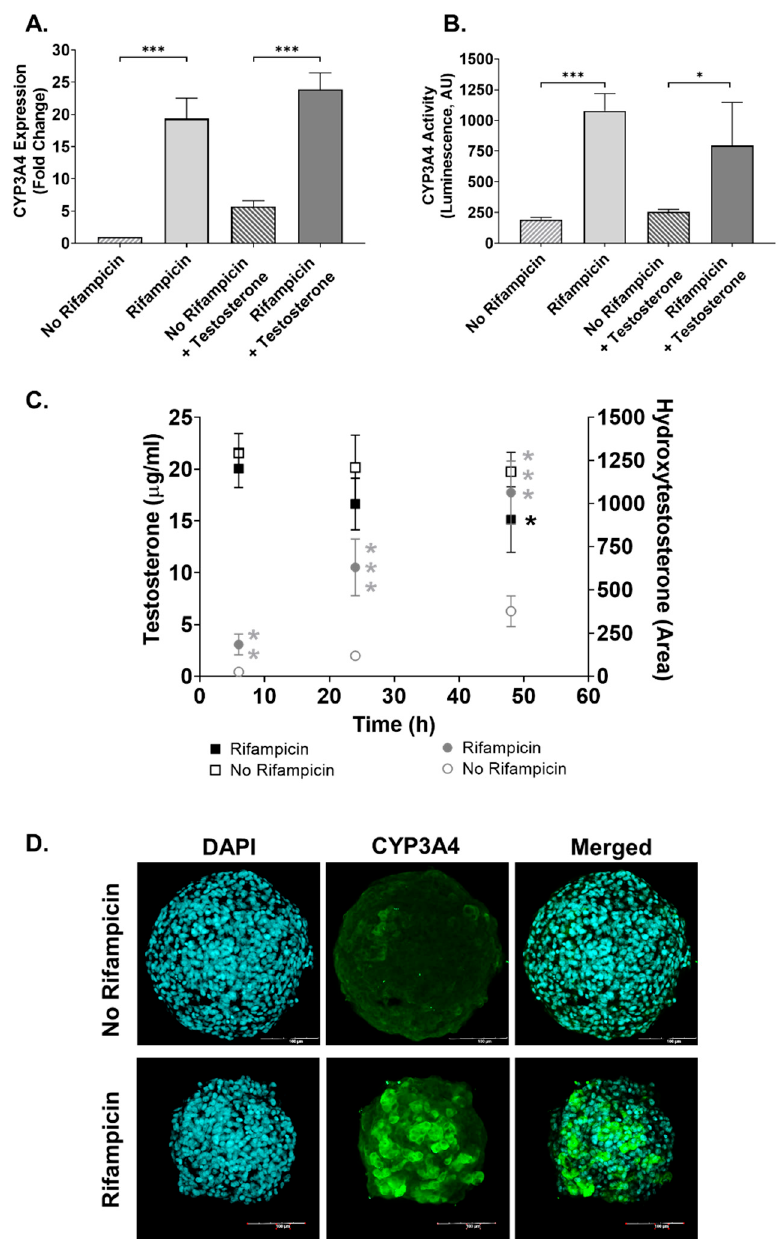
Figure 1. Characterization of CYP3A4 activity in 3D human liver MTs. MTs were exposed to 20 µM rifampicin (RIF), and RIF-treated and untreated MTs were exposed to 25 µg/mL testosterone for a further 48 hrs. Expression of CYP3A4 was determined by q-RT-PCR, expressed as fold change in comparison with the control; n = 3 ( A ). CYP3A4 activity was measured by a P450-GloTM CYP3A4 assay and expressed in luminescence arbitrary units (AU); n = 9 ( B ). Conversion of testosterone (25 µg/mL) into hydroxytestosterone (OH-testosterone) at 6, 24 and 48 h was determined by HPLC-MS/MS. Data are expressed as concentrations (µg/mL) calculated using a testosterone calibration curve. Area under the curve in arbitrary units (AU) was used for calculating OH-testosterone; n = 6 ( C ). Representative image of immunohistochemical detection of CYP3A4, scale bar = 100 µm ( D ). Bar graphs represent means ± SD; statistical analysis based on Student’s unpaired t test; boxplot represents means ± SD; statistical analysis based on Student’s unpaired t test for rifampicin v.s no rifampicin for each timepoint; *, p ≤ 0.05; **, p ≤ 0.01; ***, p ≤ 0.001.